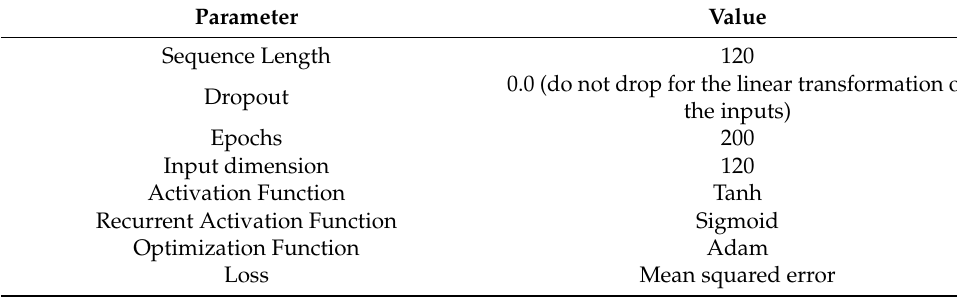
Table 5. Values used for respective LSTM model parameters.